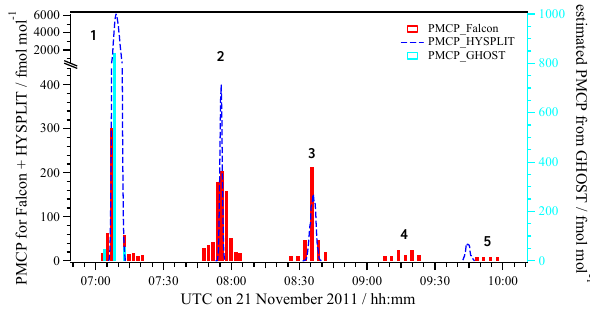
Figure 7. Time series of measured PMCP concentrations (red bars) on 21 November and HYSPLIT simulations using analyzed meteorological fields (blue dashed lines). Bluish-green bars represent the PMCP concentrations estimated from the signals of the GHOST instrument.